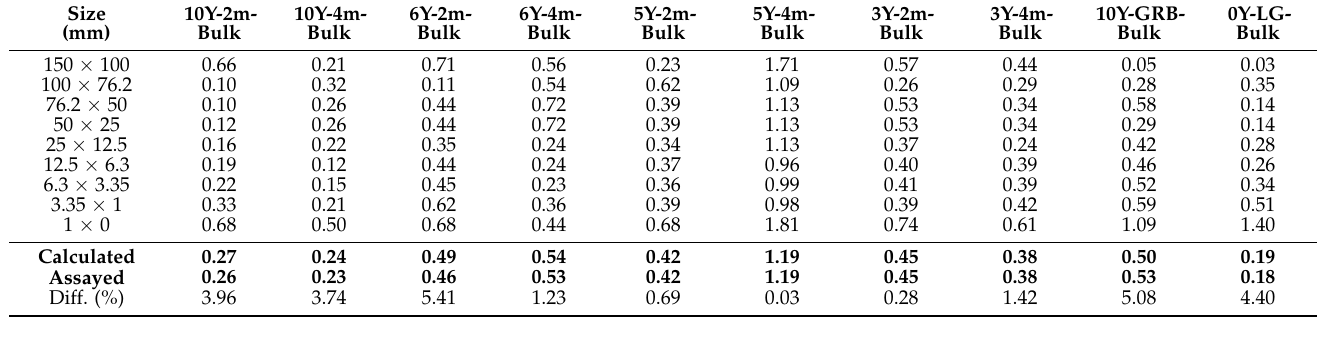
Table 5. Copper content (wt. %) of the bulk samples by size fraction.